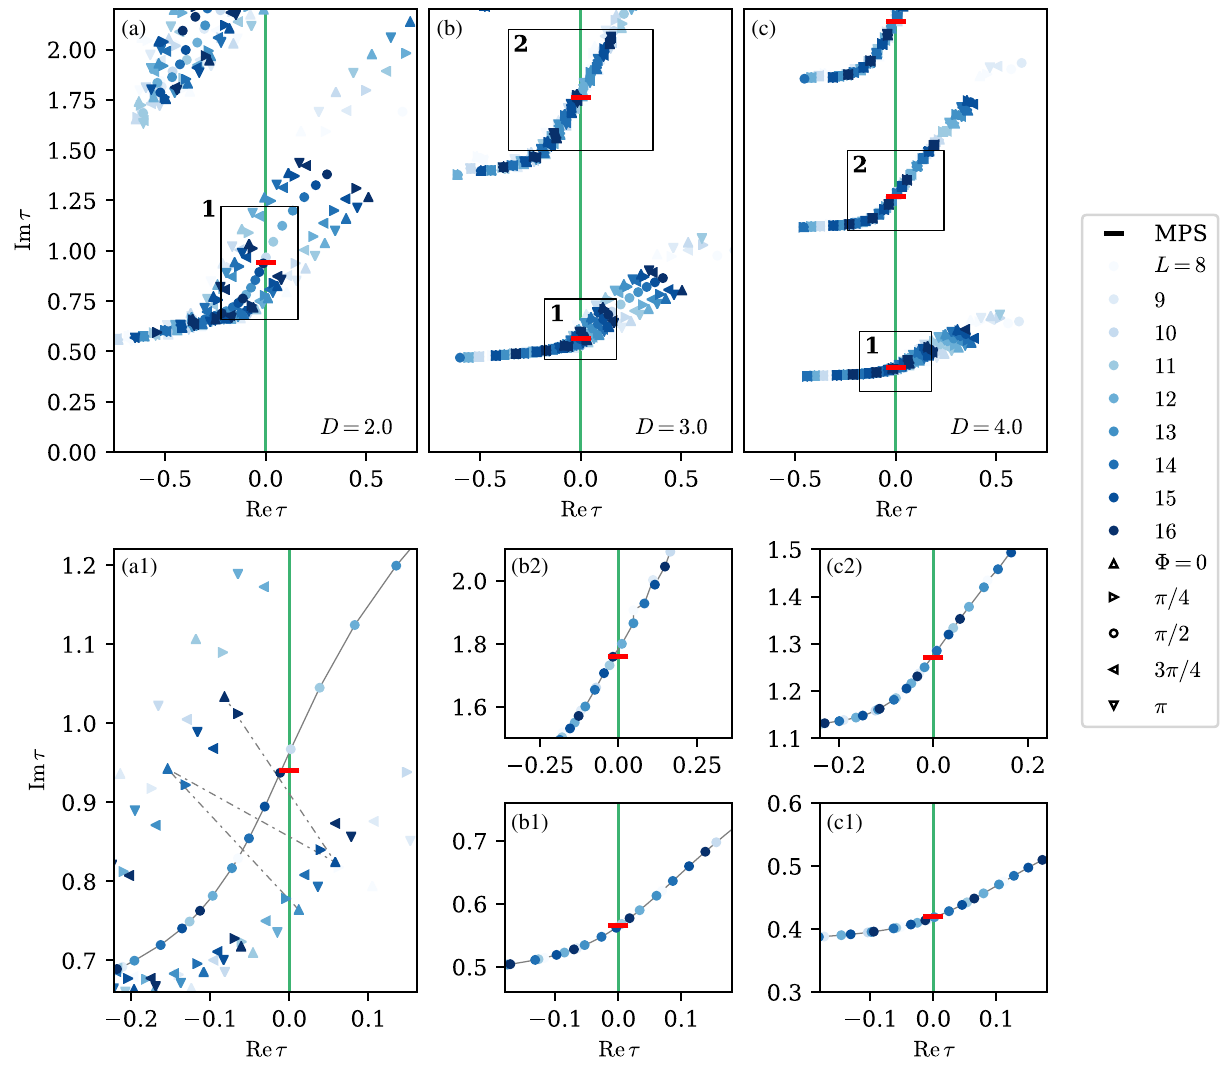
FIG. 3. Heisenberg chain. We quench the system from the Haldane phase to the large- D phase. The initial state is the ground state of the model (11) with J ¼ J z ¼ 3 B and D ¼ 0 (the AKLT state [58]). For the postquench Hamiltonian, we set B ¼ 0 , while D can take the values 2, 3, or 4. Here, J ¼ J z ¼ 1 is the unit of energy and inverse time. (a) Loschmidt zeros for D ¼ 2 . Panel (a1) is a magnified view of the area within the black rectangle in panel (a). From panels (a) and (a1), one can clearly see how the position of a Loschmidt zero for fixed L depends on the twist angle Φ , which is a finite-size effect. It is also useful to consider a fixed twist angle and vary the system size as in the case of the zeros connected by the dash-dotted line in panel (a1) ( Φ ¼ 0 , L ¼ 13 , 14, 15, 16). The finite-size dependence is suppressed for the zeros corresponding to the twist angle Φ ¼ π = 2 , defining the effective thermodynamic line of zeros (solid line, see Appendix D). The critical time, determined by the crossing of the effective line with the imaginary axis, is in excellent agreement with the result of Ref. [27] (red bar) obtained using matrix product states (MPS). (b,c) Same as in panel (a) but with D ¼ 3 , 4. Finite-size effects are suppressed with increasing D . In panels (b1), (b2), (c1), and (c2), the crossings of the effective thermodynamic lines of zeros with the imaginary axis are shown and compared again with the critical times obtained in Ref.